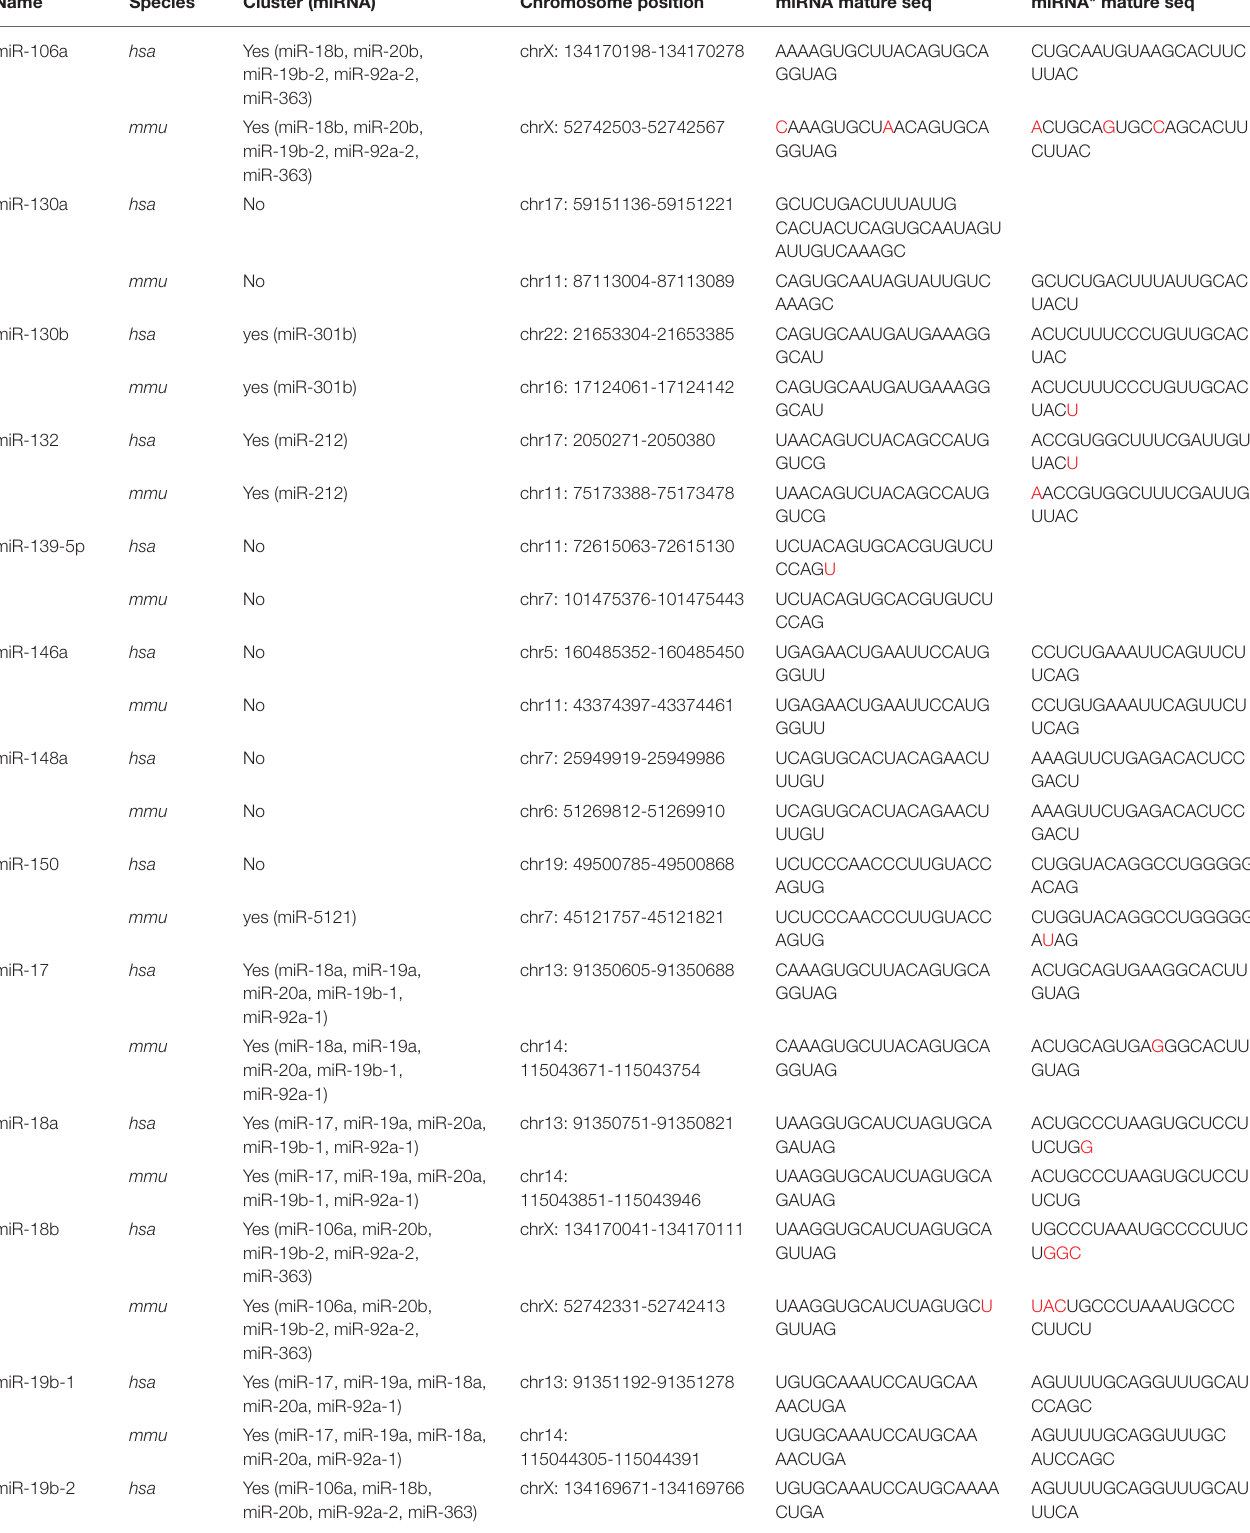
TABLE 1 | List of miRNAs common in human and mouse miRNome datasets.